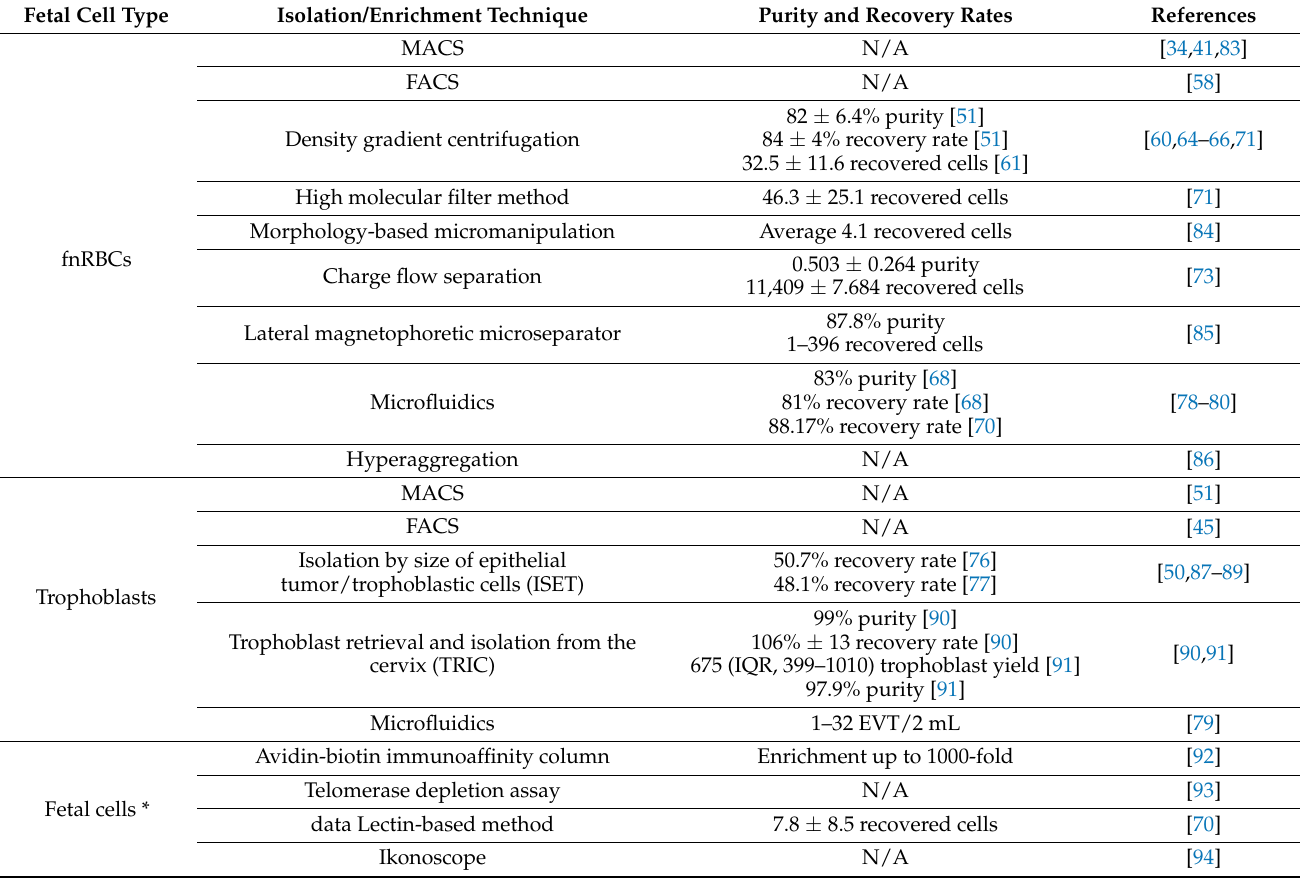
Table 2. A summary of technical approaches of isolation or enrichment of fetal cells in the maternal circulation. Fetal Cell Type Isolation/Enrichment Technique Purity and Recovery